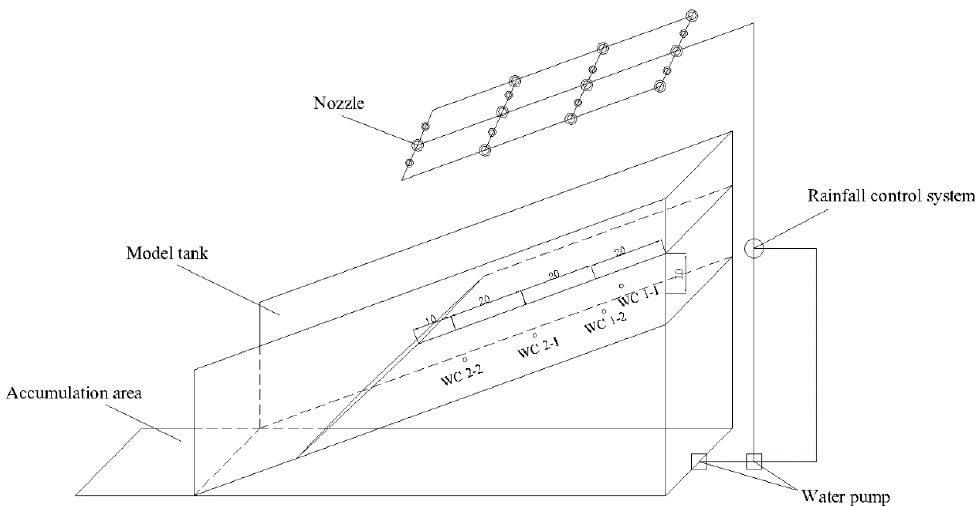
Figure 7. Physical model of Laomao Mountain debris